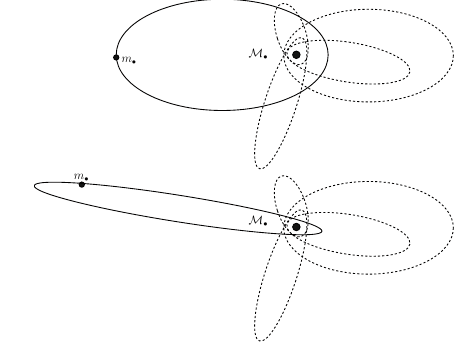
inclination of the orbital plane of a test star. Dashed lines